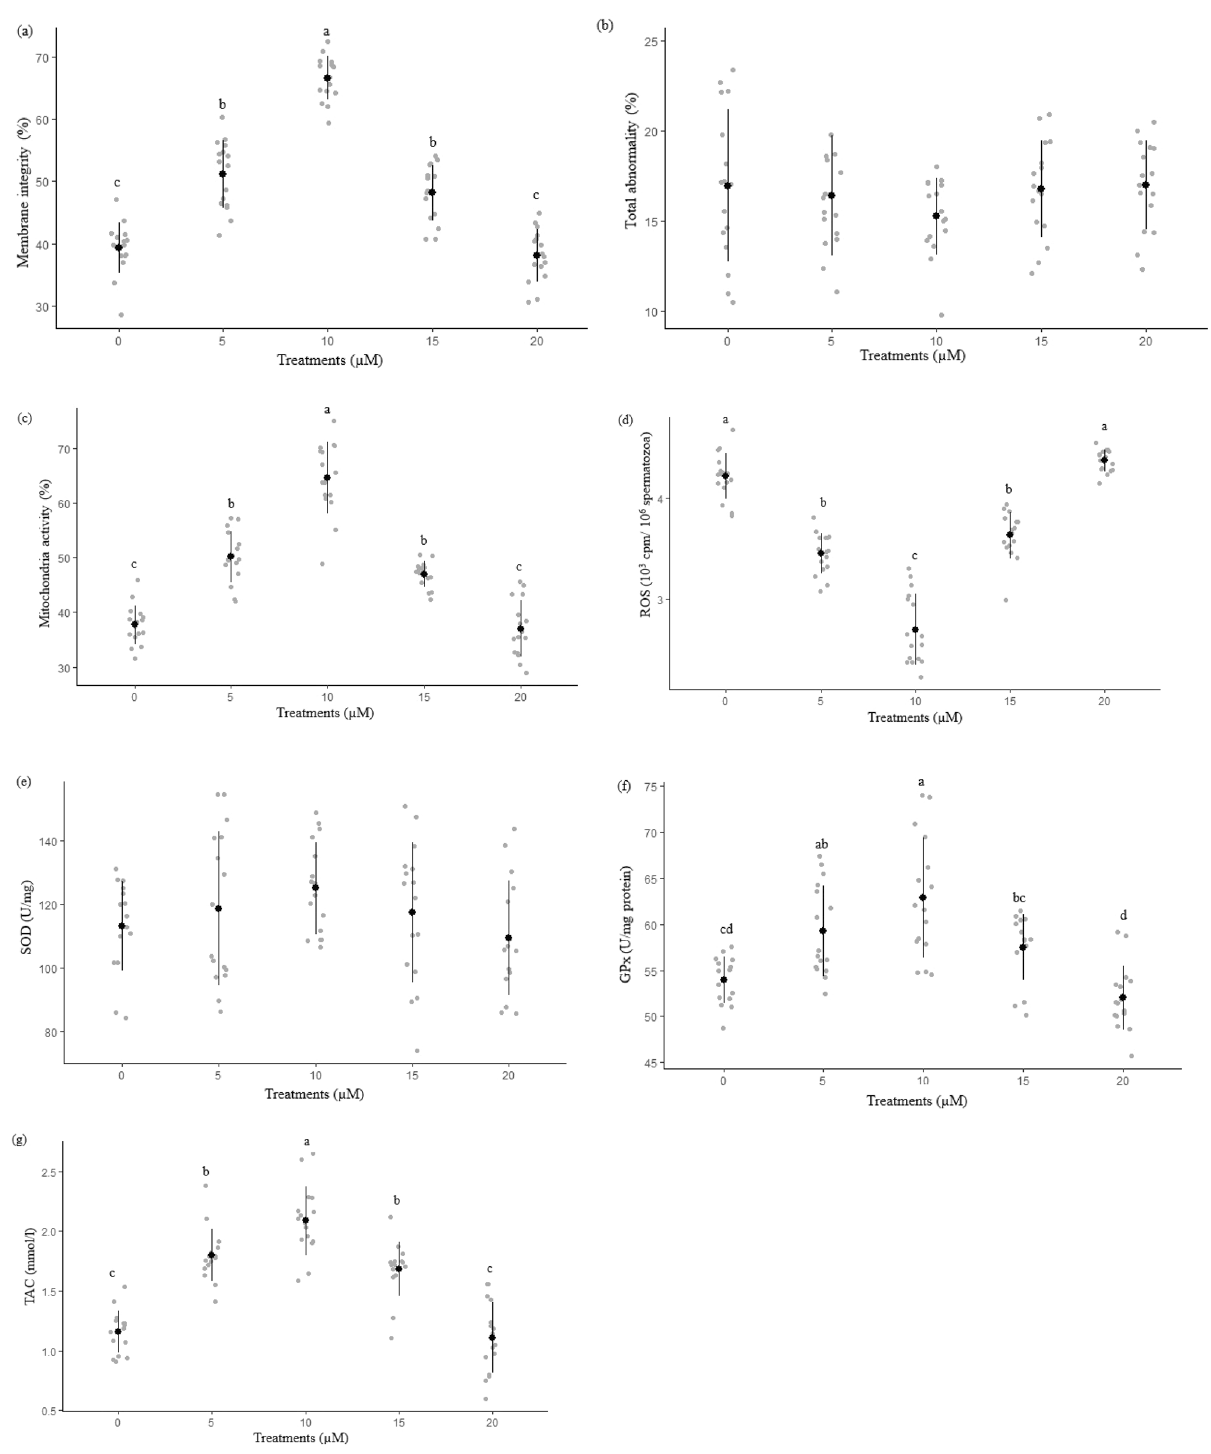
Figure 1. Membrane integrity ( a ), Total abnormality ( b ), mitochondrial activity ( c ), ROS ( d ), SOD ( e ), GPx ( f ) and TAC ( g ) after thawing samples cryopreserved with the different tempol concentrations. Different letters indicate that treatments differ P <